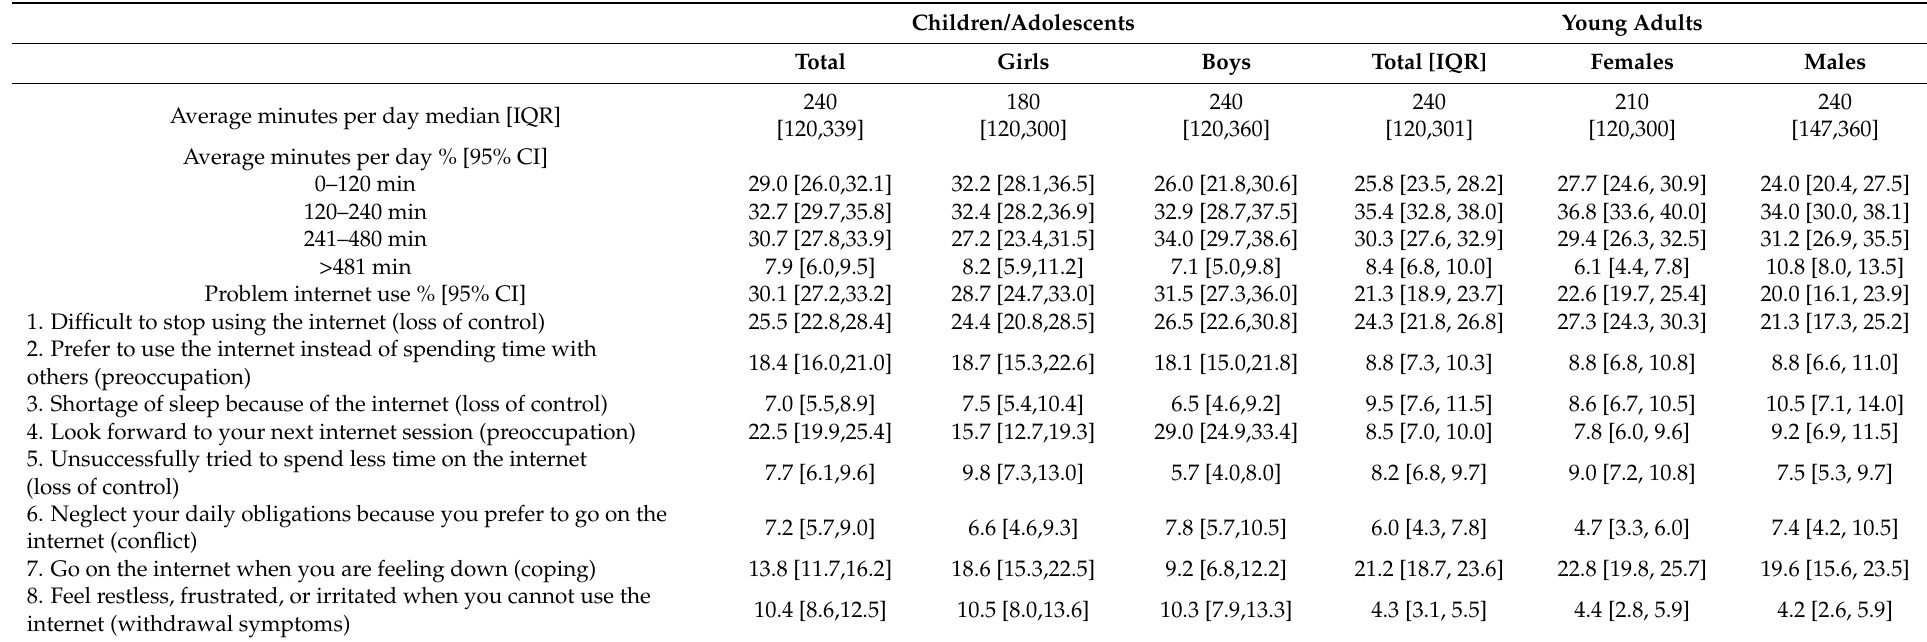
Table 6. Internet use during the lockdown due to